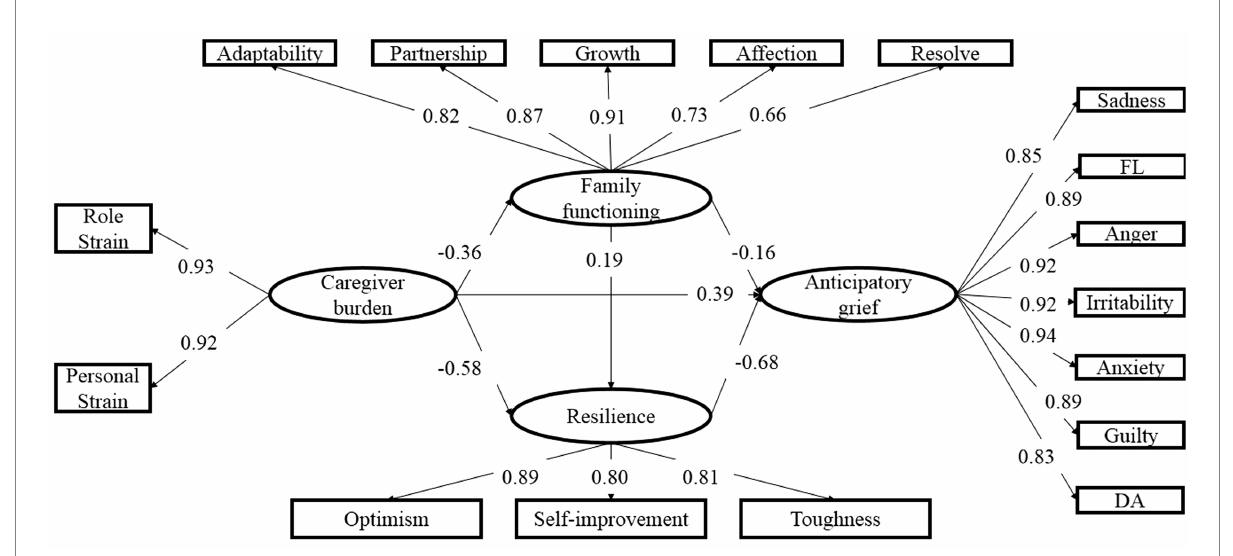
FIGURE 2 The Structural Equation Model linking caregiver burden and anticipatory grief through family functioning and resilience. Factors loadings are standardized. FL = feeling of loss, DA = decreased ability to function at usual